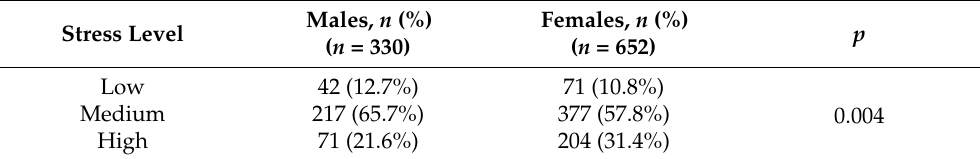
Table 4. Quantification of stress perception, according to the PSS-10 questionnaire, between males and females.